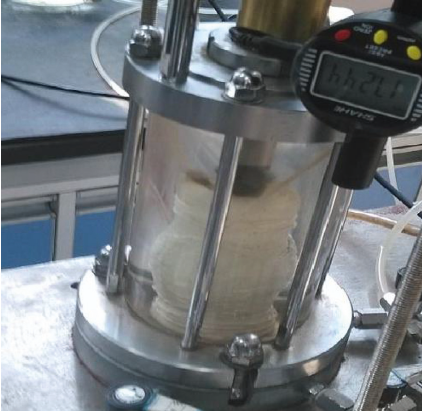
Figure 5: Failure mode of the specimen tested under the deviatoric stress of 590 kPa and the confining pressure of 100kPa.